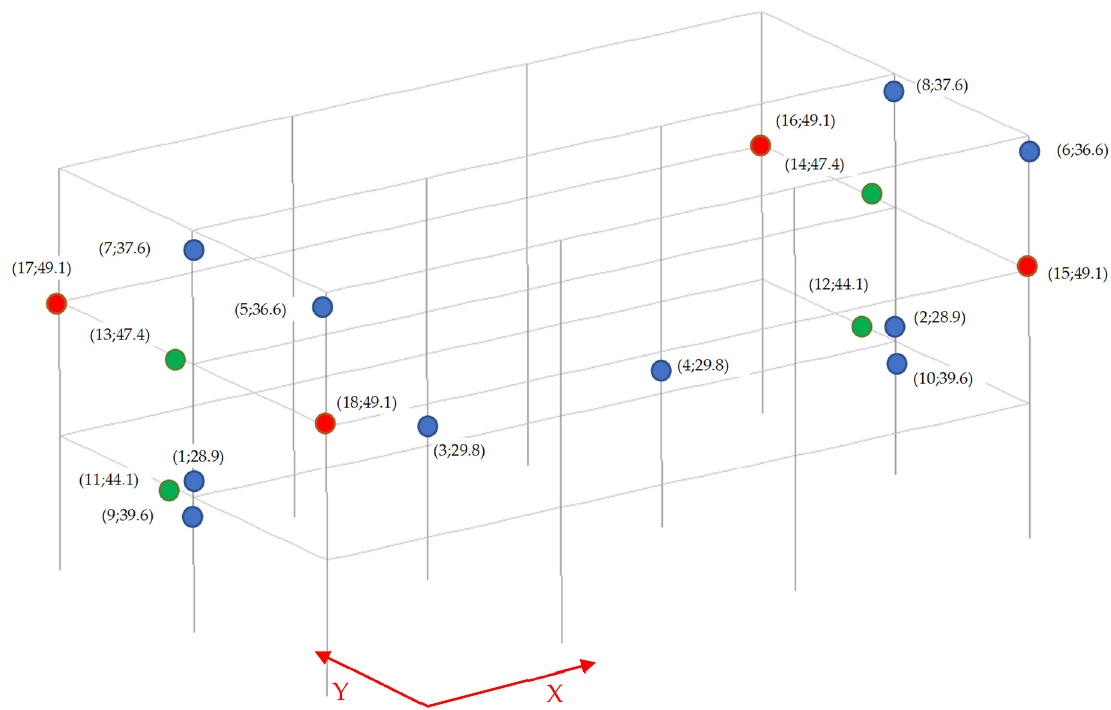
Figure 8. Activation sequence of the different non-linear behaviours attributed to the different zero-length elements.